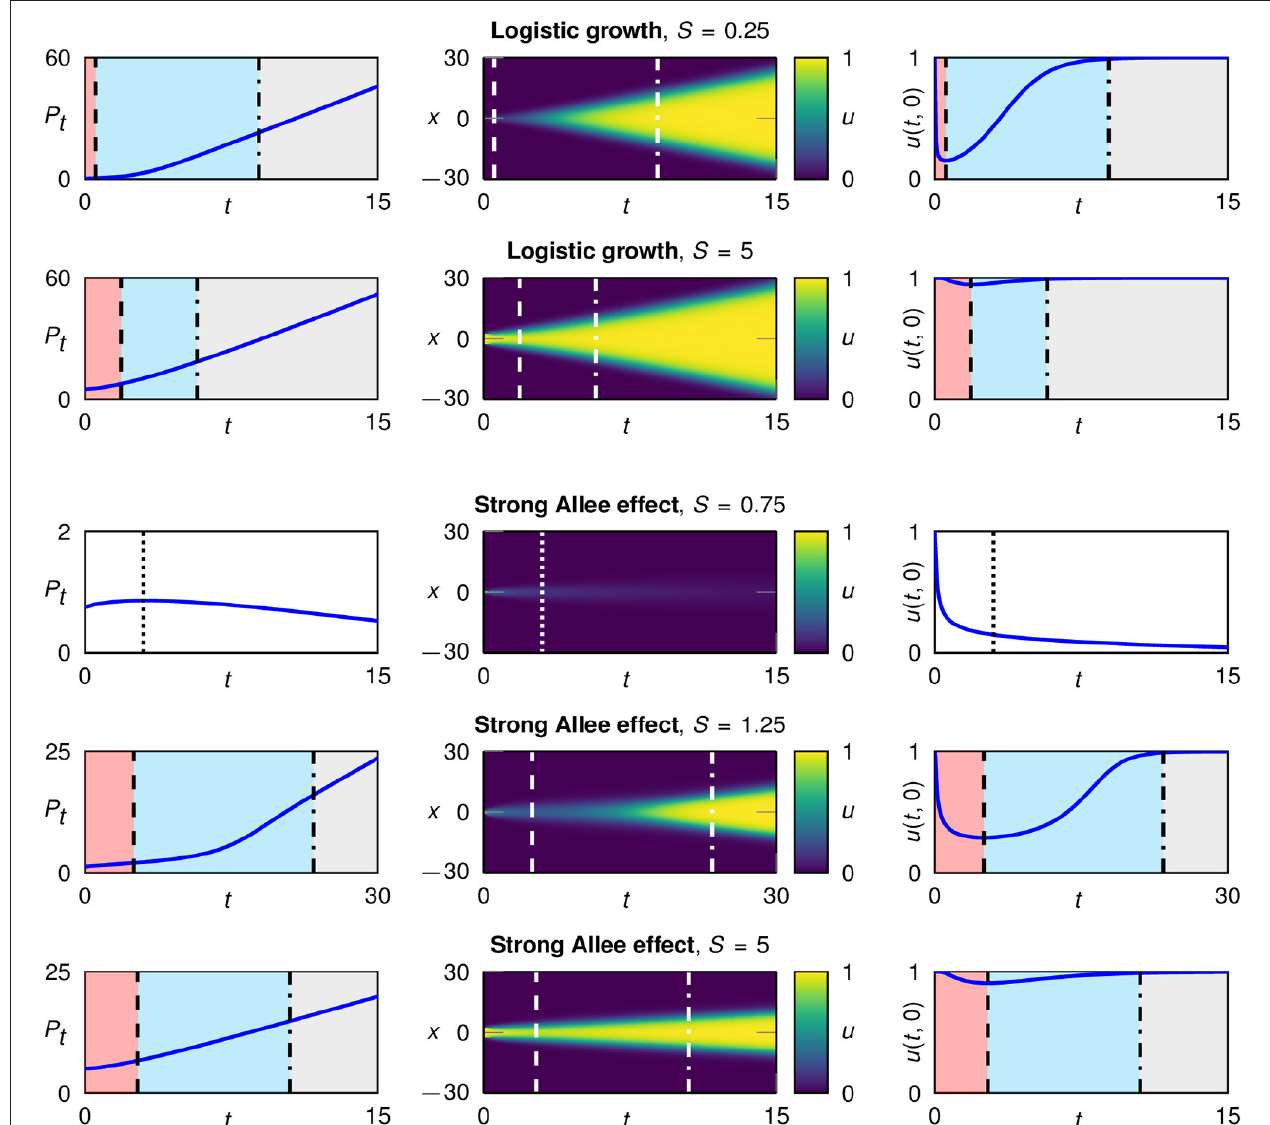
FIGURE 2 | Typical development of a population starting from single patch initial conditions with different widths, for logistic growth f L ( u ) (rows 1 and 2) and the strong Allee effect f A ( u ) with a 0.1 (rows 3–5) . Plotted are the total population size over time (left) , the spatio-temporal development in color coding (middle column) = and the population density in the center of the patch (right) . In the case of logistic growth the population survives for all patch widths; for the strong Allee